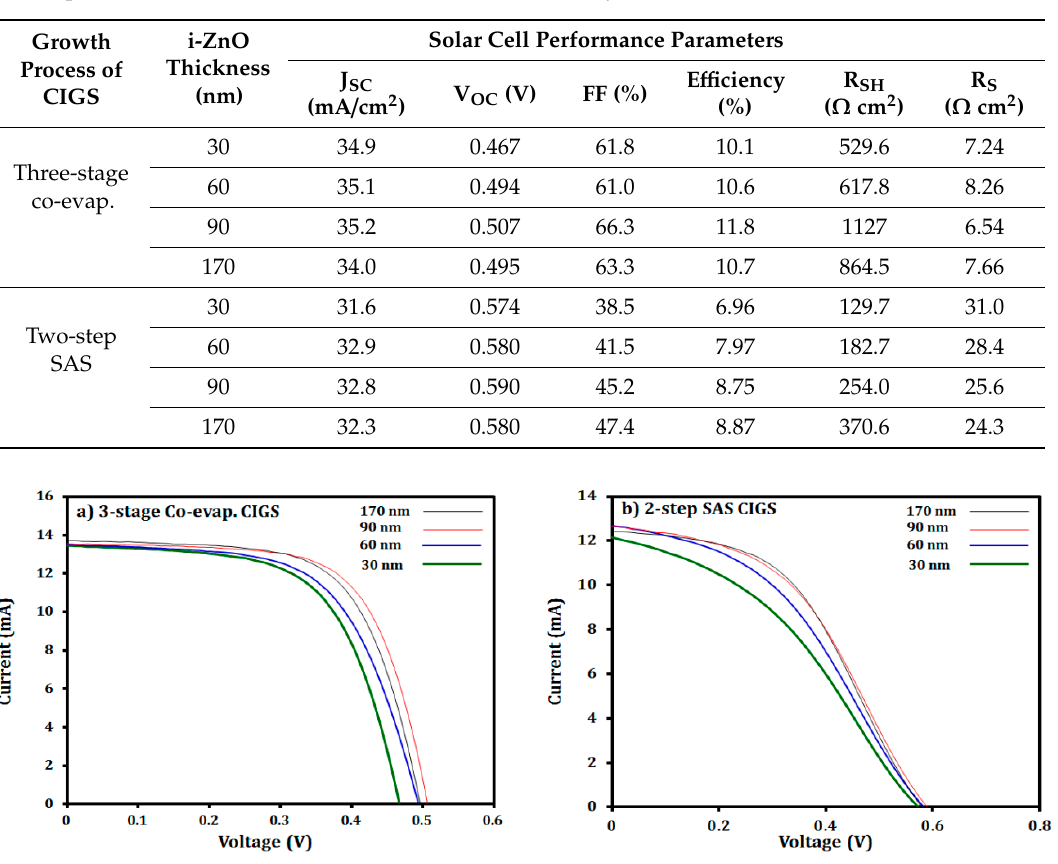
Table 2. Performance of the CIGS solar cell fabricated by the three-stage co-evaporated and two-step SAS processed CIGS absorbers as a function of the i-ZnO layer thickness.